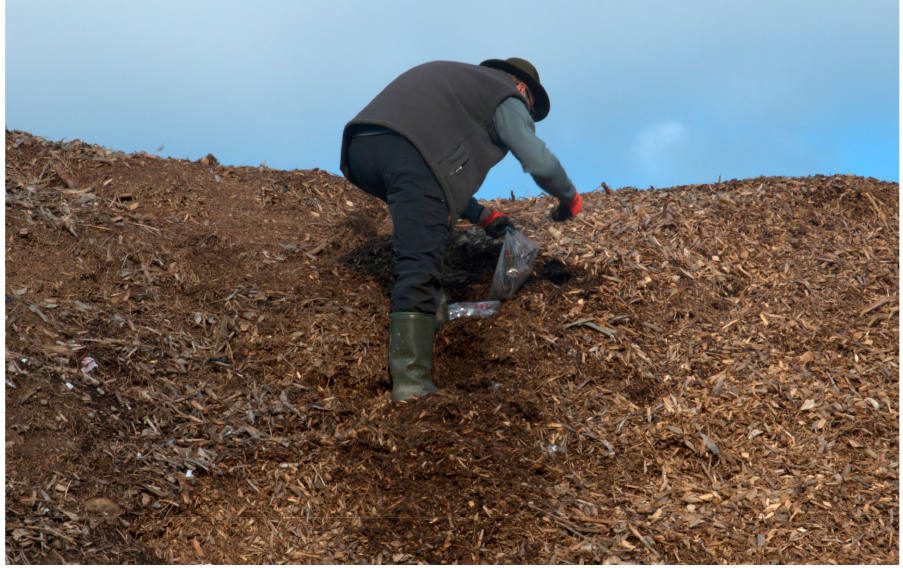
Figure 2. Sample collection in plastic